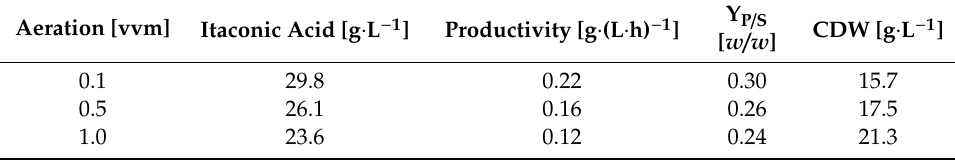
Table 3. Influence of aeration on the cultivation of U. rabenhorstiana in modified Tabuchi-medium